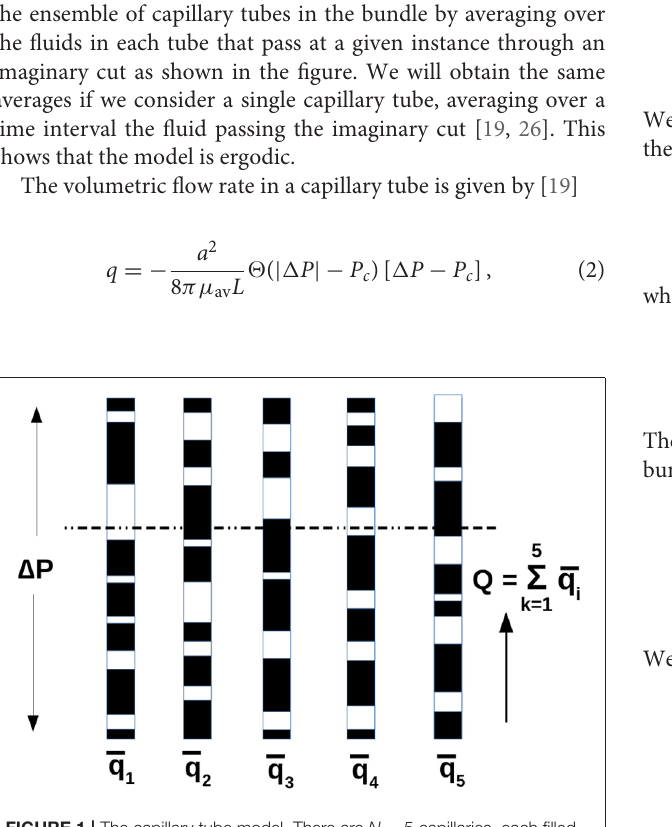
FIGURE 1 | The capillary tube model. There are N 5 capillaries, each filled = with a bubble train of wetting (white) and non-wetting (black) fluids moving in the direction of the arrow. The diameter along each tube vary so that the capillary force from each interface vary with its position. The variation in the diameters are not illustrated in the figure. The average diameters are the same for all tubes. The broken line illustrates an imaginary cut through the capillary fiber